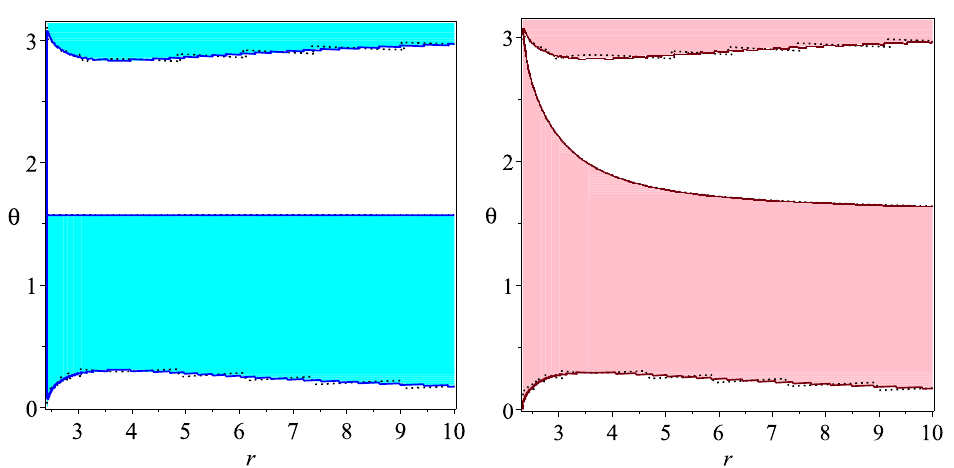
Figure 2. The orientation of the angular velocity Ω ( r , θ ) for the Taub–NUT case ( left ) and the Kerr– Taub–NUT case ( right ), where r is plotted starting from their respective event horizons. The mass M and the NUT charge n are chosen to be 1, while the rotation parameter a is set to be 0.5 for the Kerr–Taub–NUT case. In both cases, CTCs can be found in the shaded region near the south pole, and in the unshaded region near the north pole. The shaded regions have opposite rotations with respect to the unshaded region (the solid curves and lines have zero angular velocity). In particular,